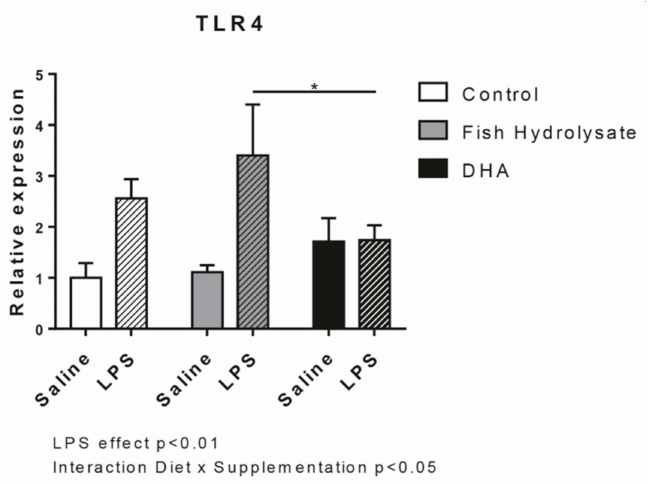
Figure 1. Expression of the lipopolysaccharide (LPS) receptor TLR4 in the hippocampus of mice fed orally with control solution (in white), fish hydrolysate (in grey) or DHA (in black) by daily gavage for 18 days, 2 h following LPS injection (125 µ g/kg) (hatched bars) (* p < 0.05 by 2-way ANOVA and Fisher’s LSD post hoc test; n = 4–6 per group). Data are presented as mean ± SEM. DHA: docosahexaenoic acid; LPS: